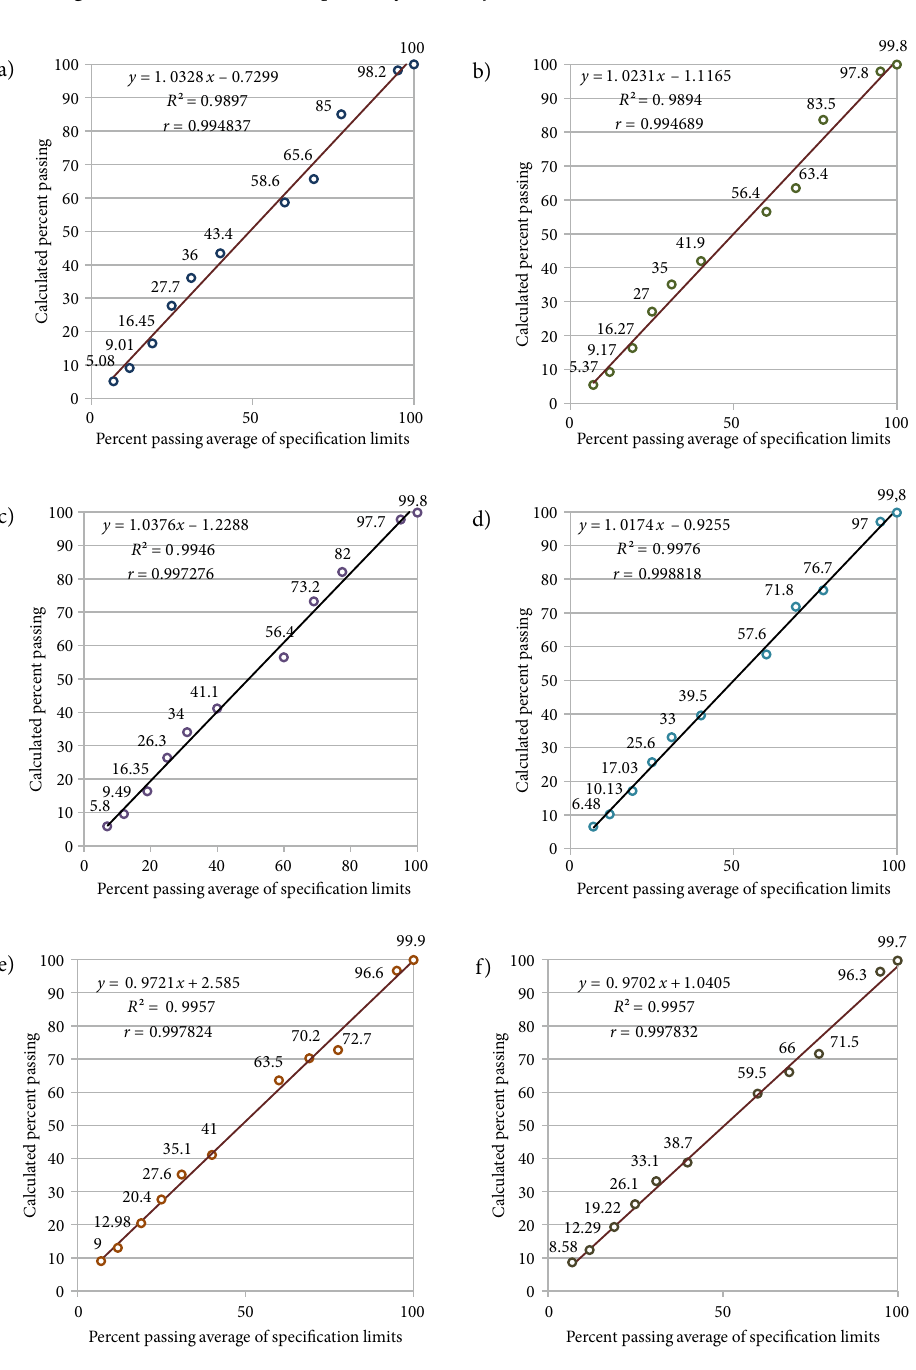
Fig. 3. The correlation of the averages of percent passing of specification limits and percent passing of the designed asphalt mixture under no technological limitations (a, b, c, d) when the imported filler had to make more than 3% and quartz sand had to make less than 20% (e,